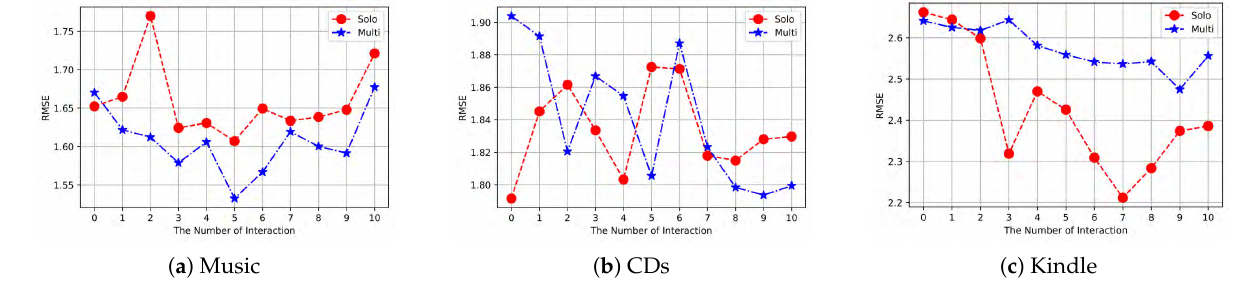
Figure 5. RMSE performance of MPUSMs and DRBM-Social on three users with different vector dimensions during 10